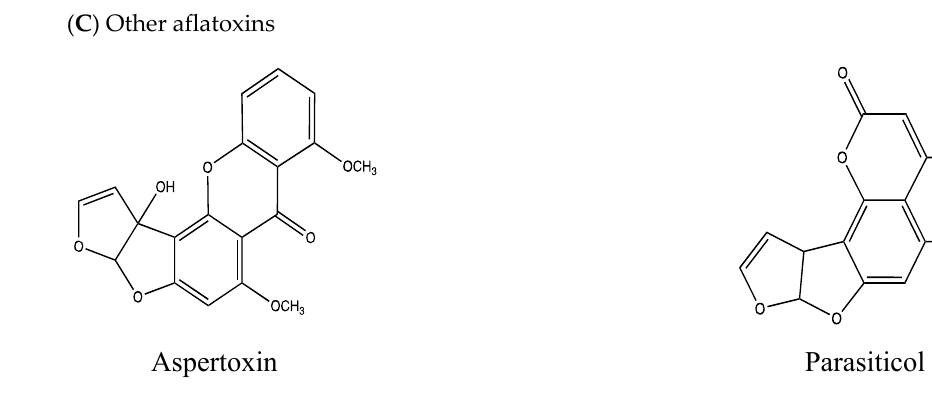
Figure 1. Diversity of chemical structures of aflatoxins in the difurocoumarocyclopentenone ( A ) and the difurocoumarolactone ( B ) groups. Aspertoxin, a difuranoxanthane, and parasiticol, lacking the lactone ring of its parent aflatoxin G1, are occasionally considered as standalone mycotoxins ( C ).